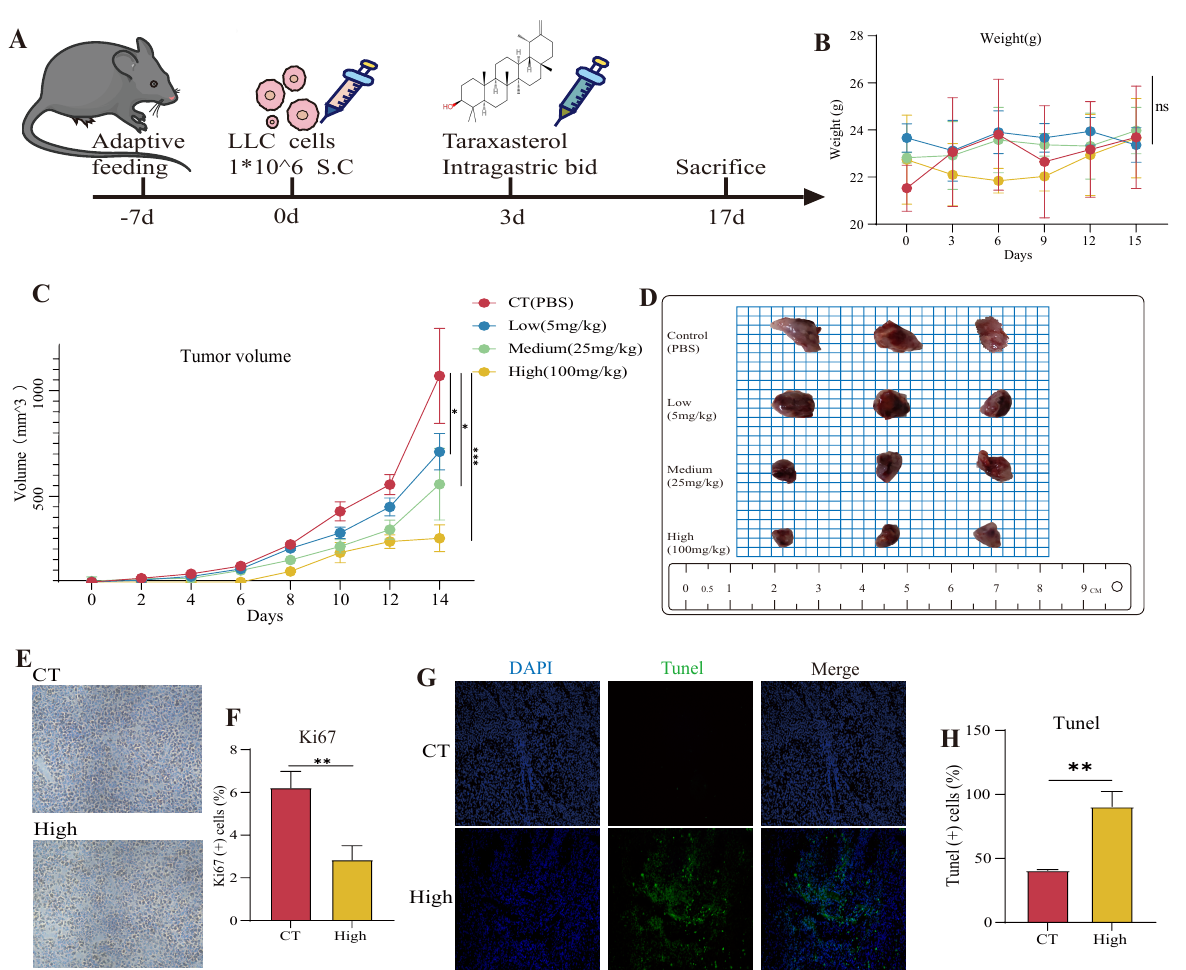
Figure 6. TAX exerts antitumor effects in vivo: ( A ) Subcutaneous tumor inoculation and admin- istration schedule in mice. ( B , C ) Body weight and tumor volume in mice. ( D ) Tumor image in mice. ( E , F ) Immunohistochemistry of ki67 staining and statistical analysis of tumor tissue. ( G , H ) TUNEL fluorescence detection and statistical analysis of tumor tissue. ns, not significant, * p < 0.05, ** p < 0.01, *** p < 0.001. (Student’s t -test). Data are presented as mean ± stdv. Furthermore, we evaluated the possible side-effects caused by TAX in vivo. The en- zymes reflecting liver and kidney function, and the morphological alterations of vital organs were examined. It showed that TAX neither affected the serum biochemical biomarkers of liver and kidney including aspartate aminotransferase (AST), alanine aminotransferase (ALT), creatinine (Cre), or blood urea nitrogen (BUN), nor altered the morphology of the heart, spleen, liver, or kidney as detected by H&E staining (Figure 7A,B), suggesting that TAX treatment did not cause detectable toxicity in mice. This data is consistent with the safety assessment performed by preliminary bioinformatics, as well as the results of the cellular experiments (Figures 1F and